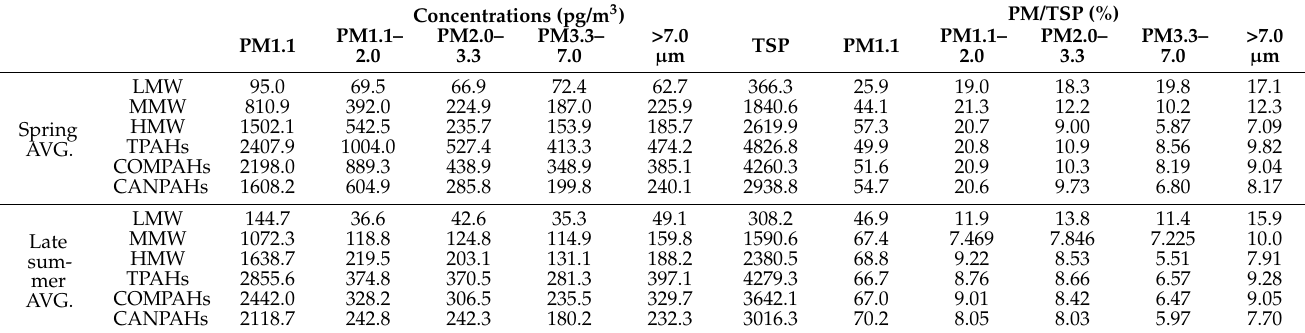
Table 3. Average concentration and percentage of LMW, MMW, HMW, COMPAHs, and CANPAHs in five-range ambient particles during the sampling and late summer sampling periods.